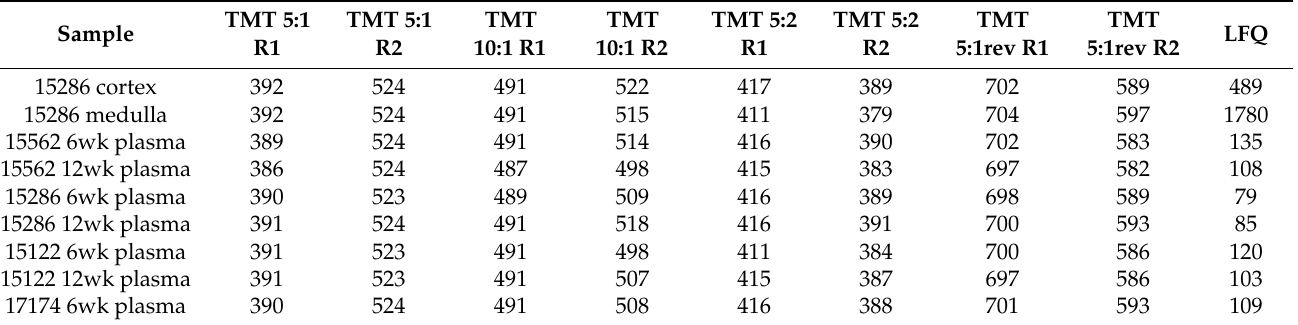
Table 2. Number of protein groups identified in the analysis of each sample. Detailed results for each experiment can be found in the Supplementary Tables